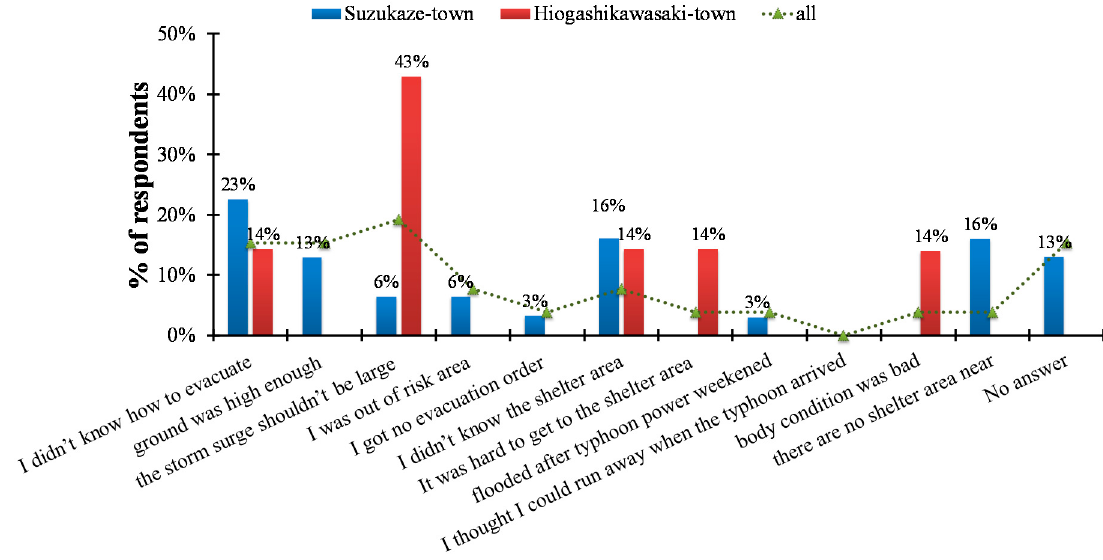
Figure 16. Reasons cited by respondents for not evacuating (note that multiple answers were allowed in this question, n = 4 for Higashi-Kawasaki town, n = 12 for Suzukaze town).